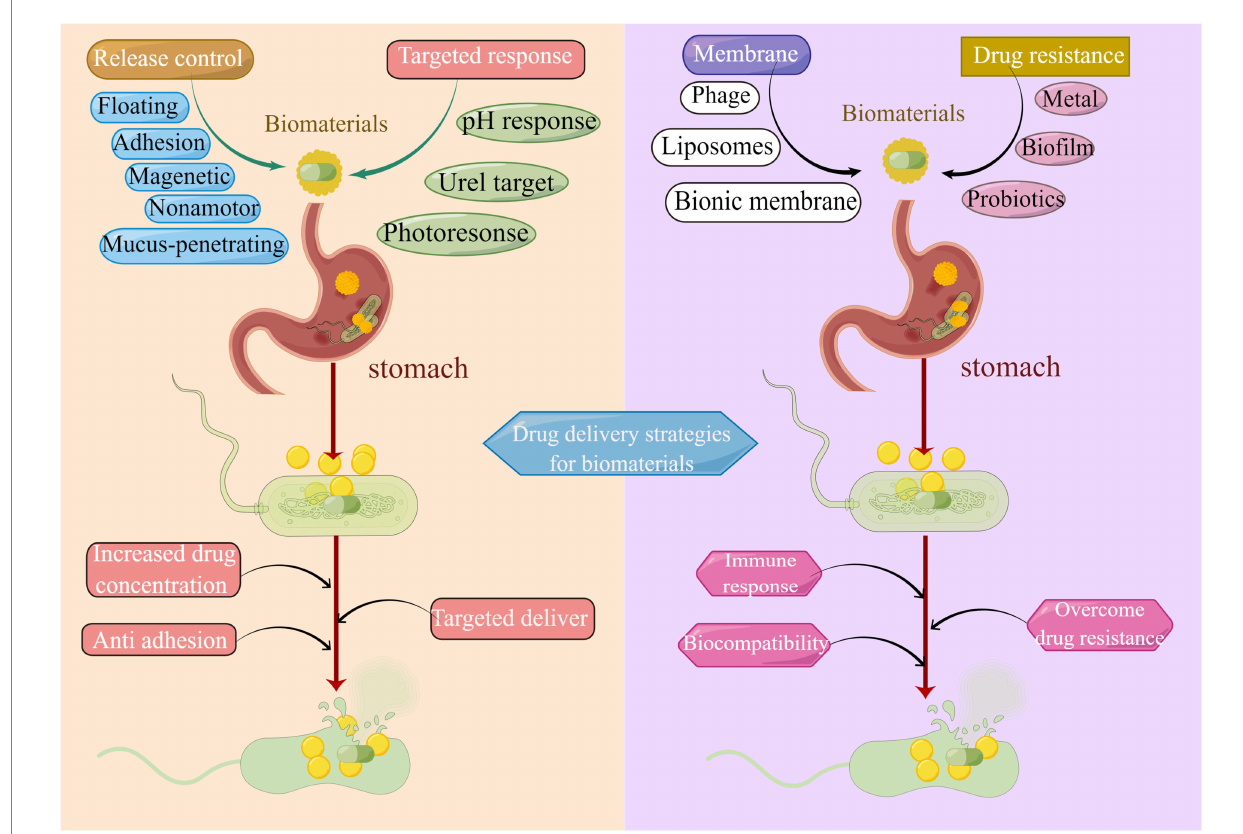
FIGURE 8 Drug delivery strategies of biomaterials in H. pylori eradication. Common strategies utilized for drug release control include bioadhesion, mucosal penetration, floating raft, nanomotor, and magnetic materials. Methods applied for targeted drug delivery are pH response, Urel targeting, and photo response. Biomimetic biological membrane materials are liposomes, cell membranes, and phages. Strategies to overcome drug resistance include metal materials, probiotic materials, and the elimination of